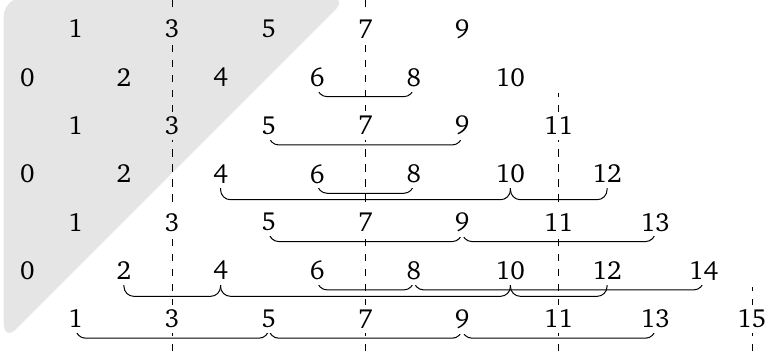
Figure 2: Bratteli diagram for b